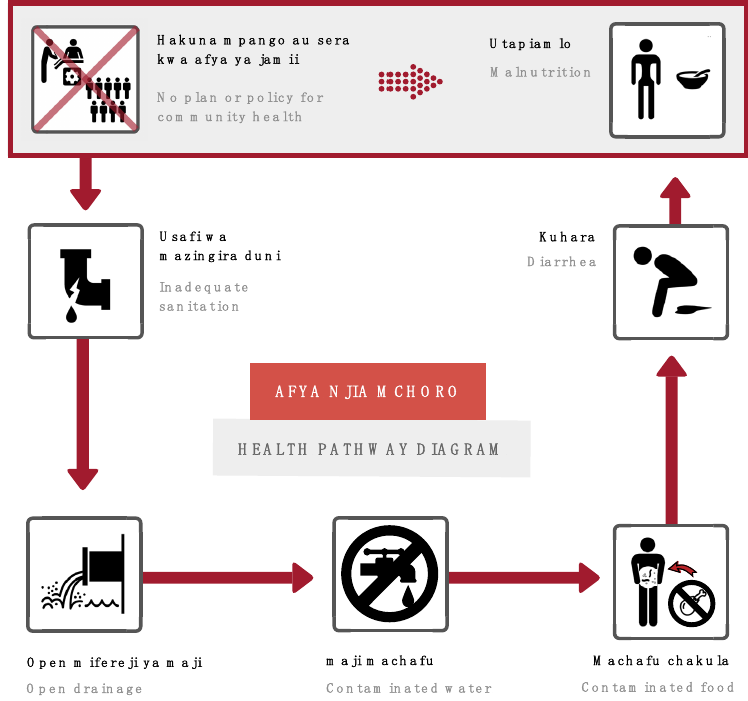
Figure 8. Community Planning Graphic Used to Prevent Diarrheal Diseases.